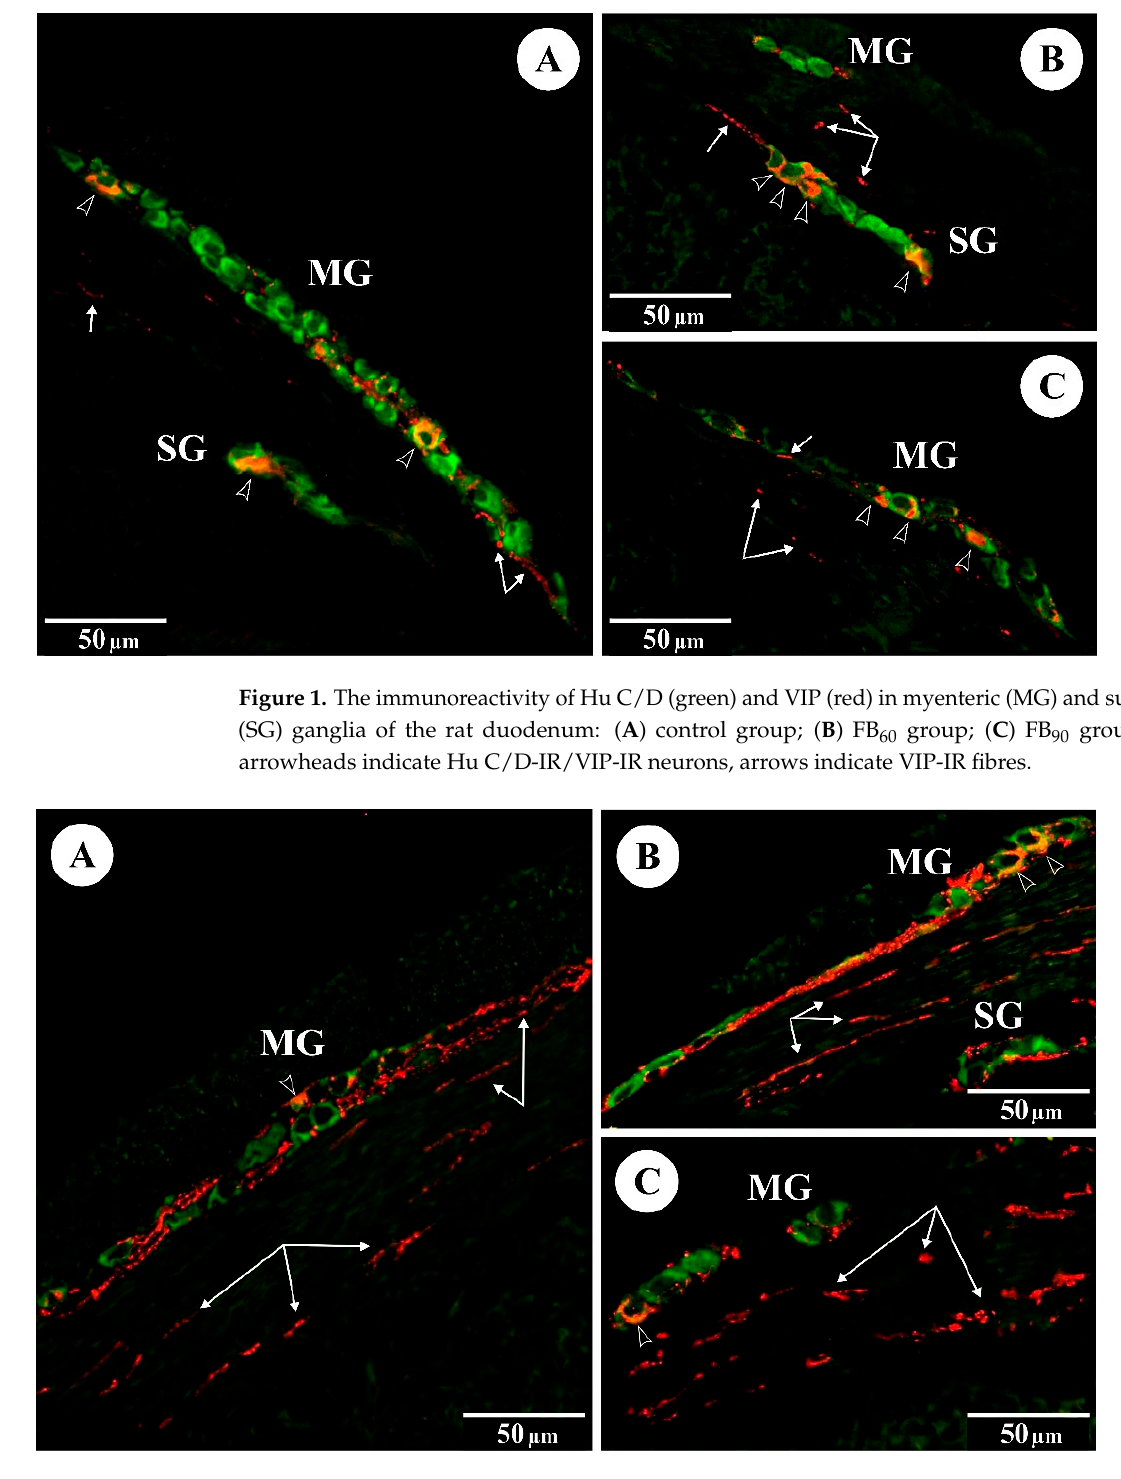
Figure 2. The immunoreactivity of Hu C/D (green) and galanin (red) in myenteric (MG) and submucosal (SG) ganglia of the rat duodenum: ( A ) control group; ( B ) FB 60 group; ( C ) FB 90 group; empty arrowheads indicate Hu C/D-IR/galanin-IR neurons, arrows indicate galanin-IR fibres.